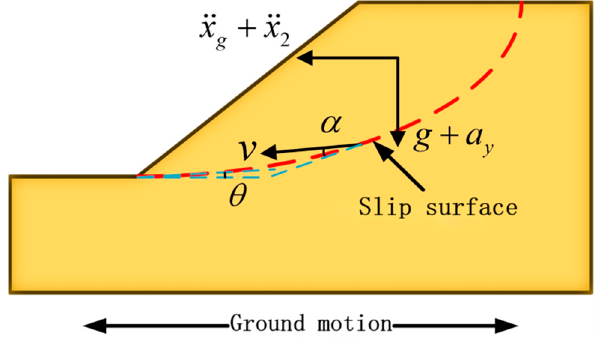
Figure 6. Calculation diagram of positive critical acceleration.